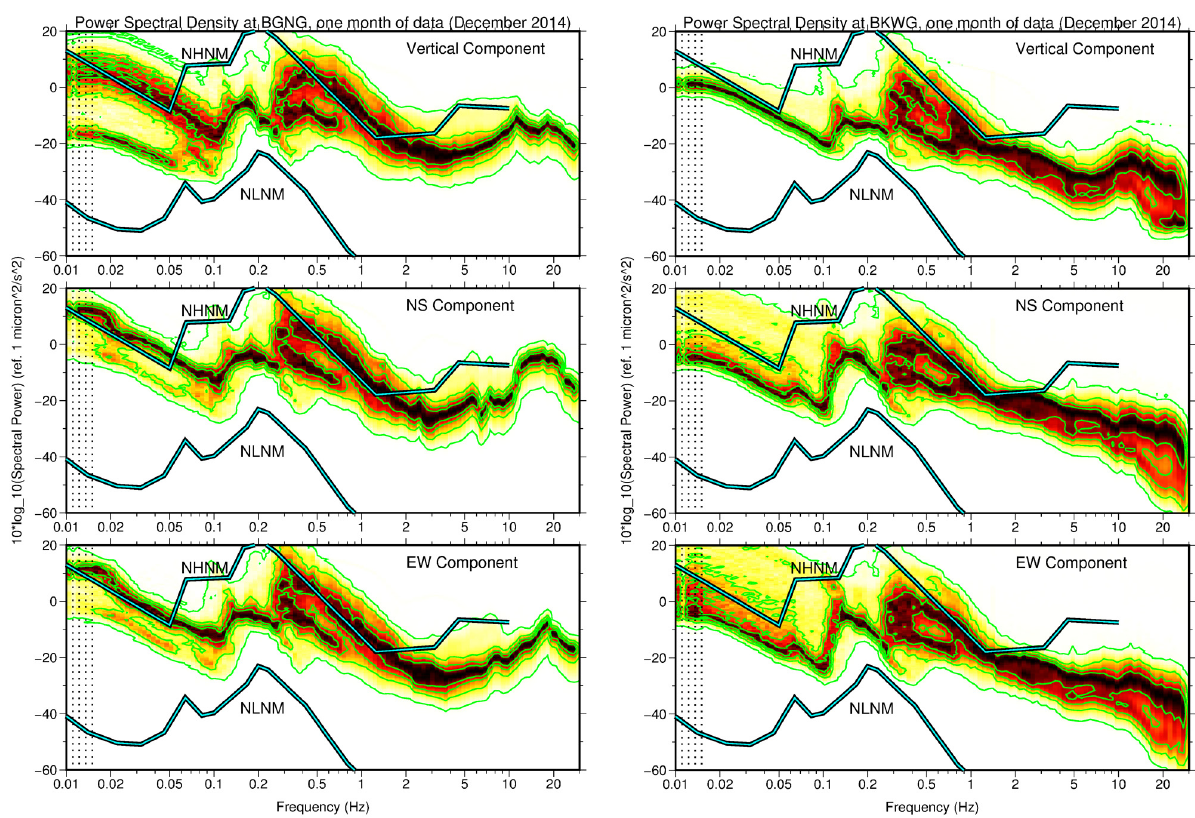
Figure 3. Example of PSD computed over one month of data at two stations, one in Campi Flegrei (BGNG, left) and one at Vesuvius (BKWG, right). For each station the three component PSD are shown and compared with the NLNM and